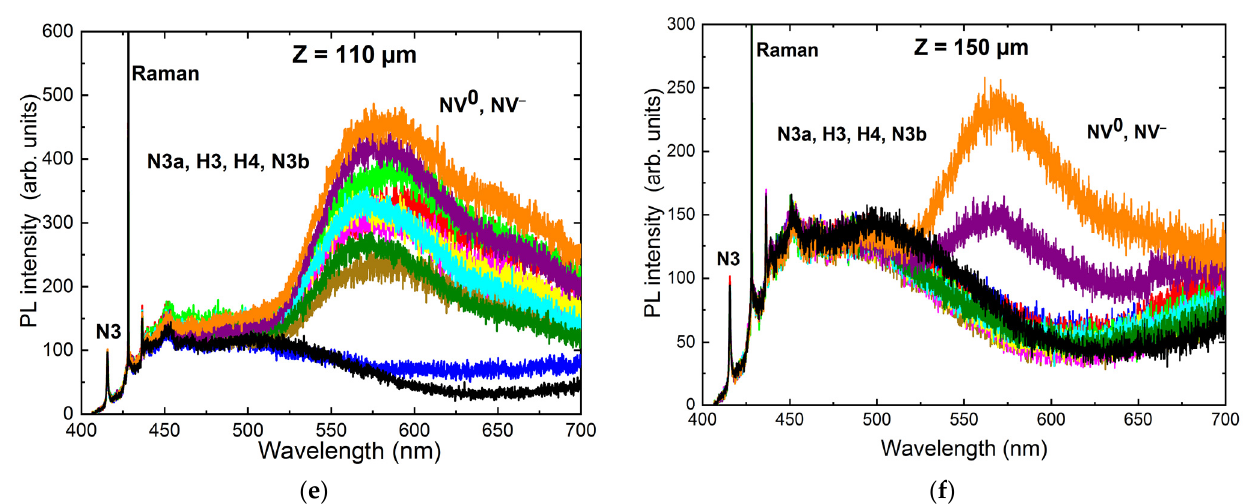
Figure 7. The 405 nm PL spectra of the micromarks at the 20 µm ( a ), 80 µm ( b ), 90 µm ( c ), 100 µm ( d ), 110 µm ( e ), and 150 µm ( f ) depths for 240 s exposure time (24M pulses) and the different incident 0.3 ps laser pulse energies (µJ).